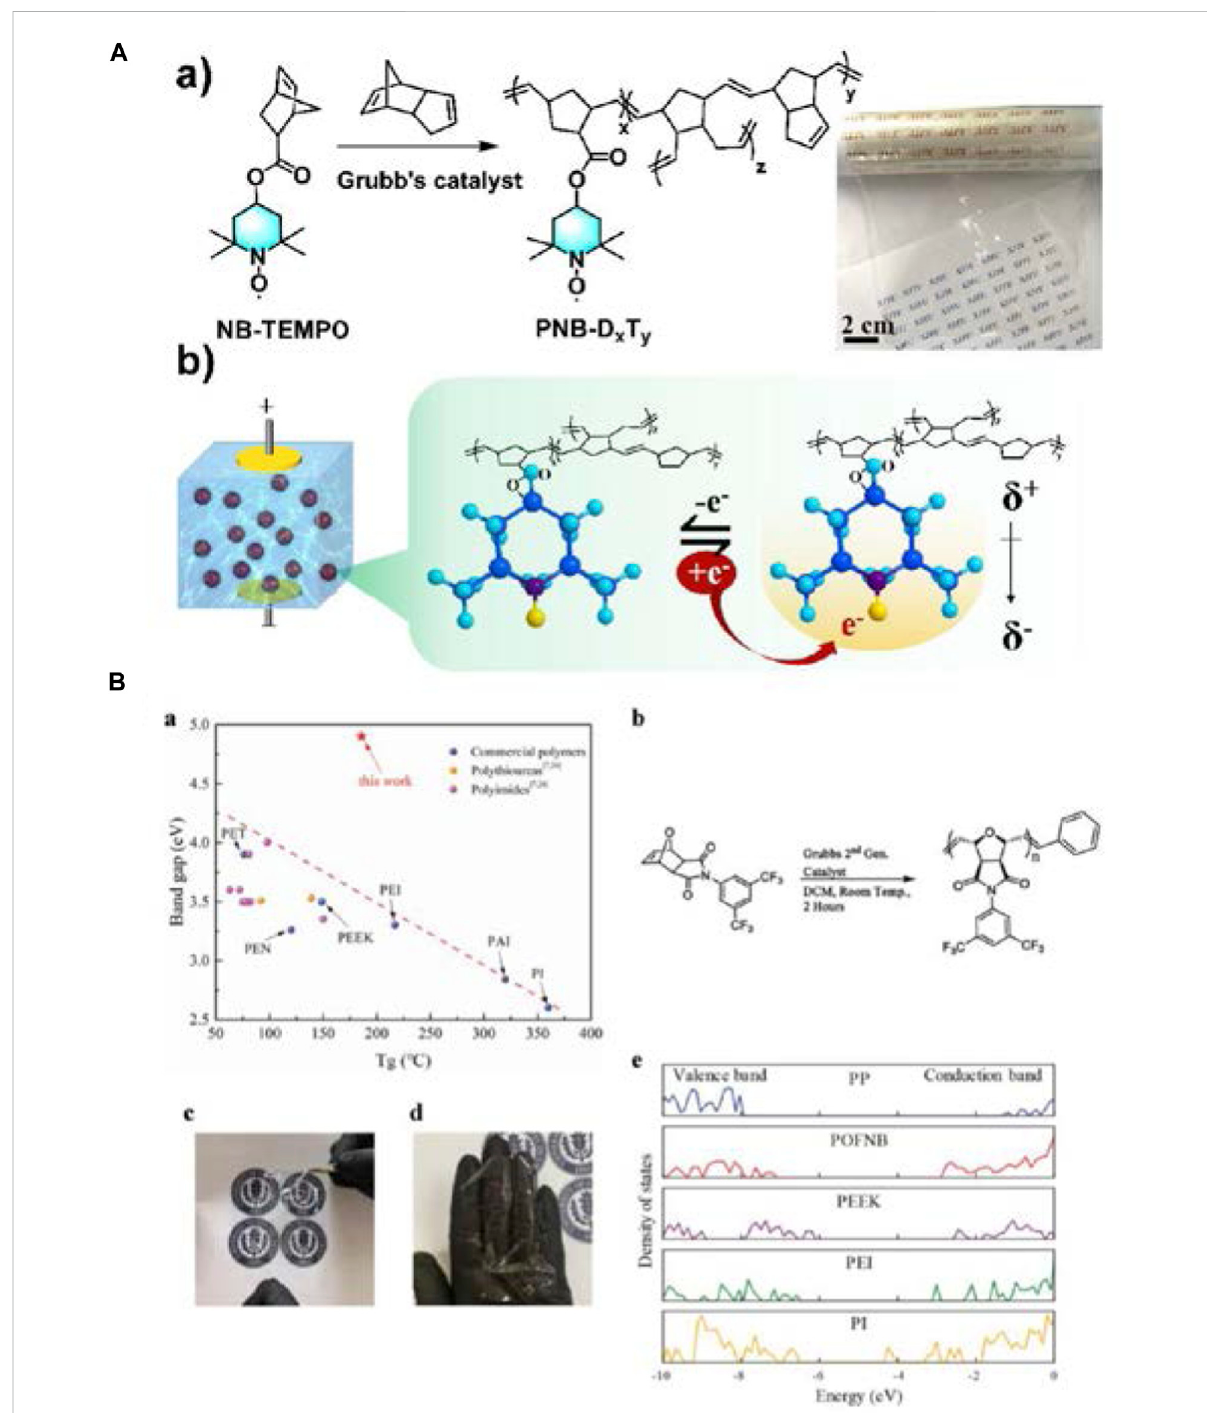
FIGURE 6 (A) Chemical synthetic route and dipole formation mechanism: (a) Chemical synthetic route of PNB-DxTy and dielectric fi lm obtained by one- step polymerization, cross-linking, and solution casting; (b) Single radical capturing electrons under an electric fi eld and the resulting dipole; (B) (a) The bandgap versus. T g for POFNB and high-temperature polymers with aromatic backbone structure; (b) Schematic of the synthesis process for POFNB; (c,d) Photographs of the free-standing POFNB fi lms; (e) The electronic density of states of POFNB, PP, PEEK, PEI, and PI, computed based on density functional theory. Reproduced with permission from Ref. 74 and 75. Copyright 2020 American Chemical Society and Wiley Periodicals,